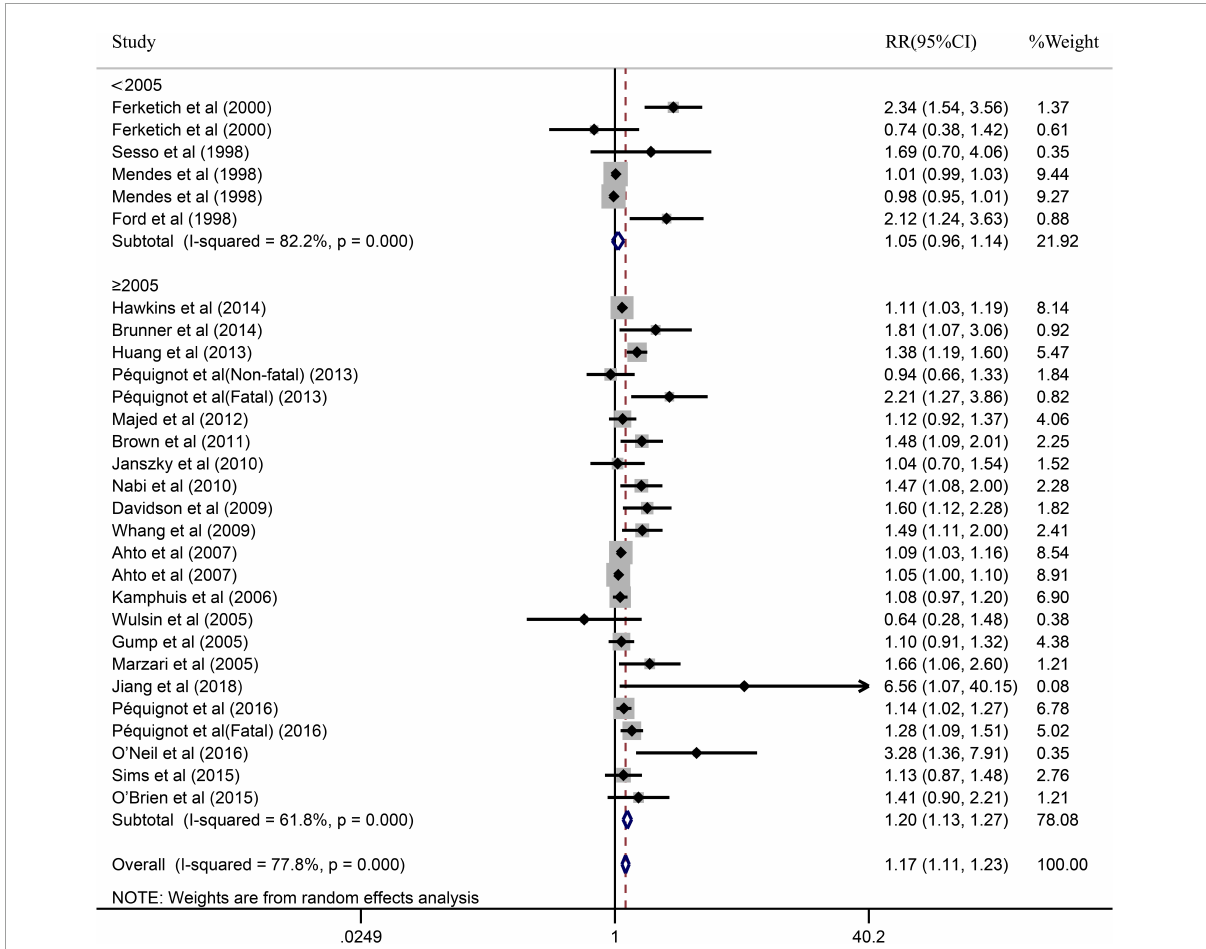
FIGURE5 Subgroup analysis with publication year ( < 2005 or ≥ 2005) presents the association between depression and the risk of coronary heart disease in a prospective cohort